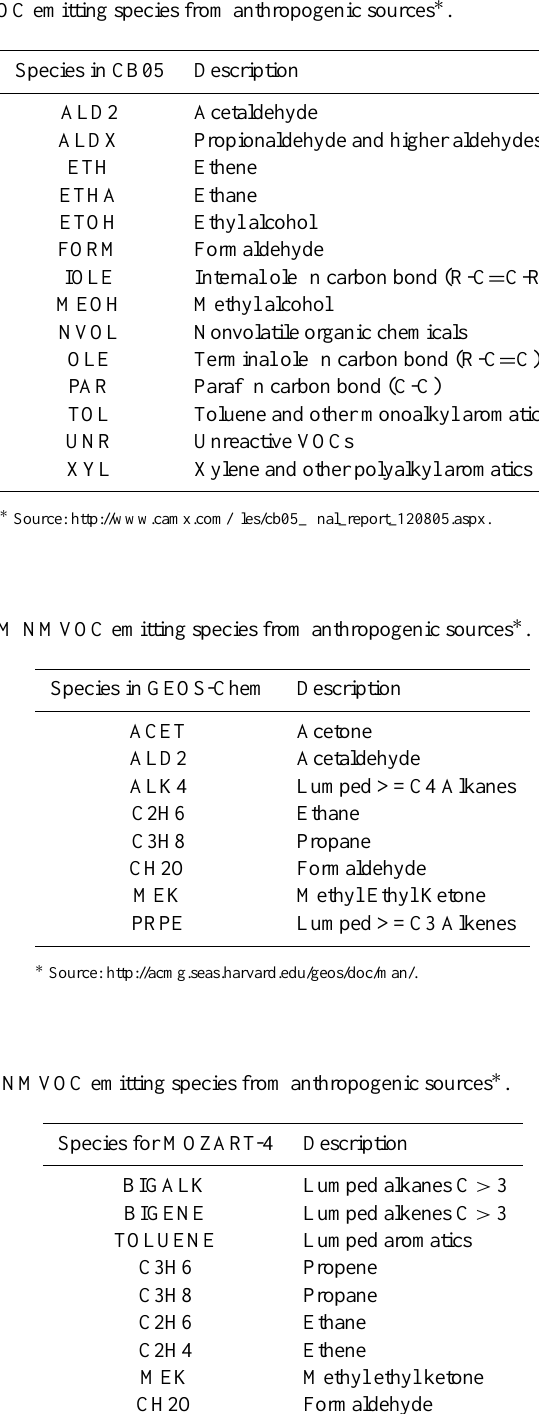
Table A2. Description of CB05 NMVOC emitting species from anthropogenic sources ∗ .